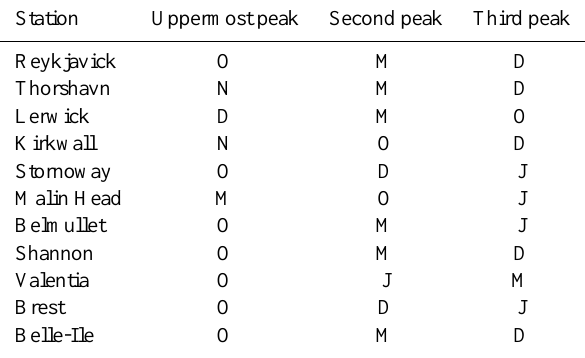
Table 2. Months between October and March, at each station con- sidered, exhibiting peaks in the angle of wind origin (using sum of